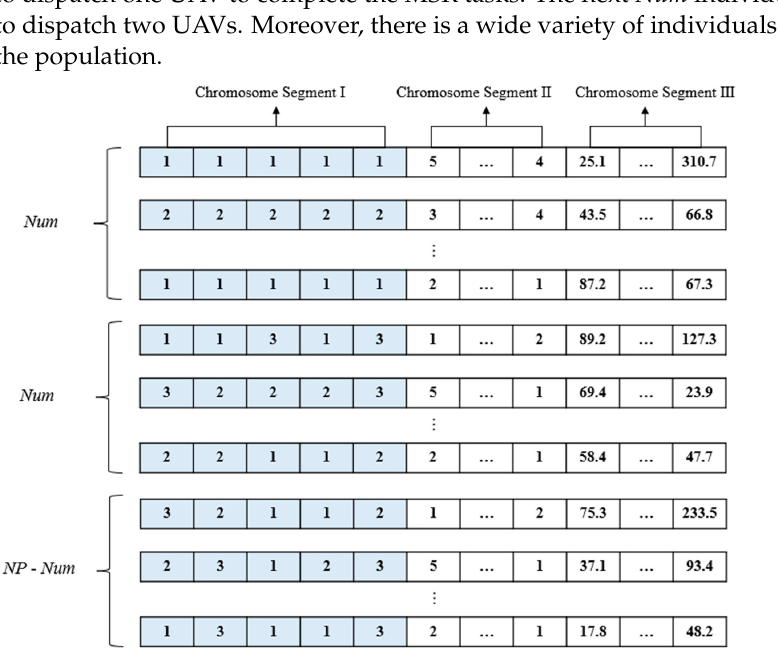
Figure 5. The proposed population initialization method.